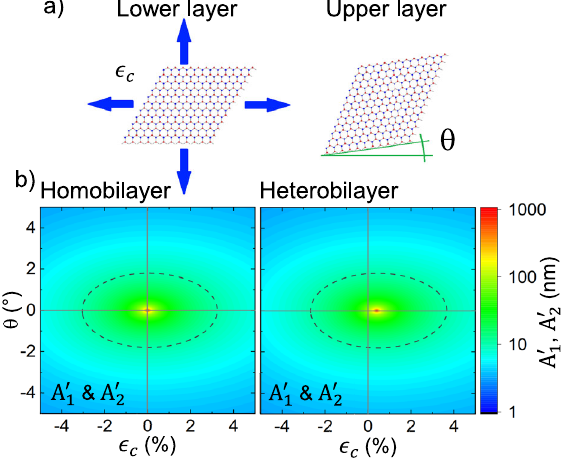
Fig. 2 Moiré lattice deformation in hexagonal bilayers under biaxial heterostrain. a Sketch of the moiré lattice formation. To perform the calculations, the biaxial strain ϵ c , indicated through blue arrows, is applied to the lower layer. The upper layer is stacked with an angle θ respect to the lower one. b Moiré lattice parameters A 0 and A 0 as function of biaxial strain and stacking angle for homo- 2 (left) and heterobilayer (right)